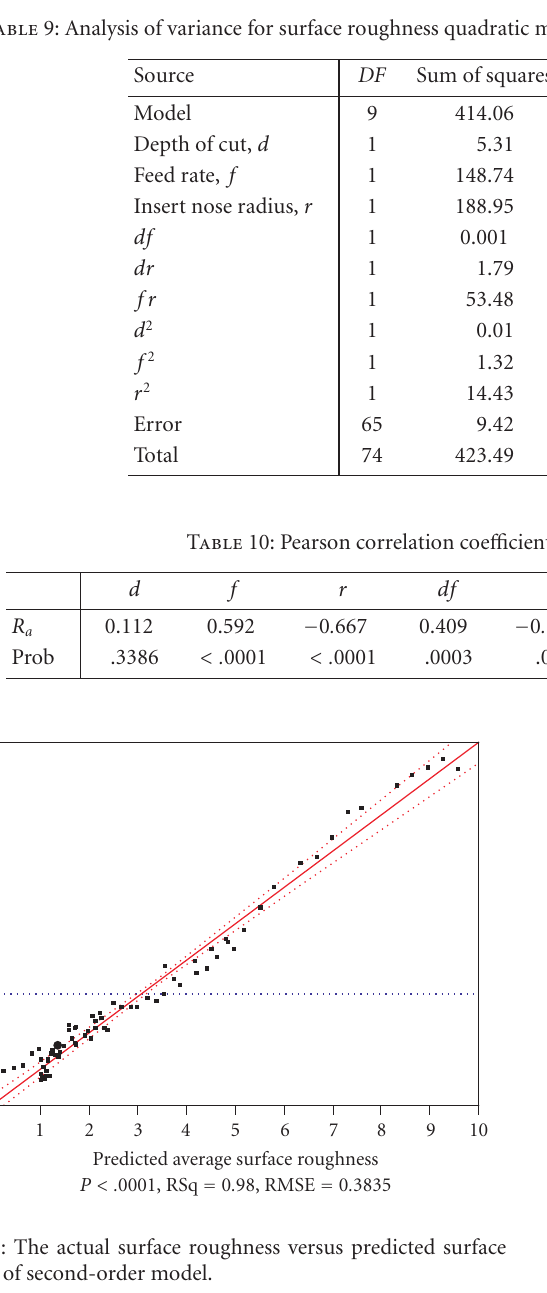
Figure 3 corresponds to the R a values for the training